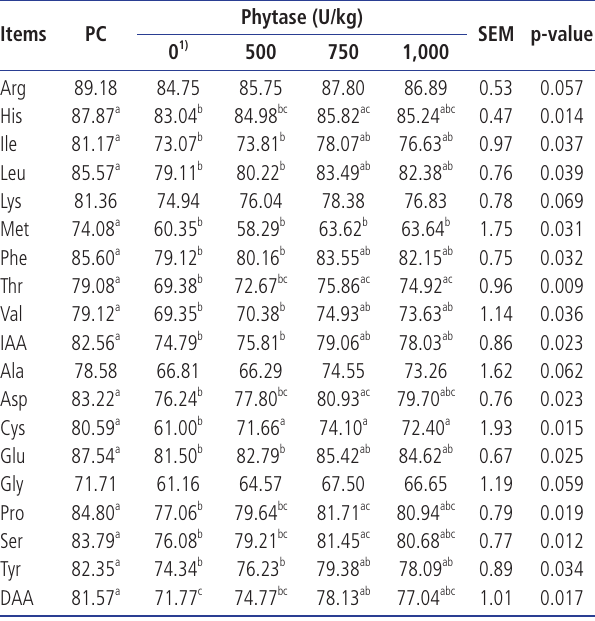
Table 6. Effect of phytase on apparent ileal digestibility of amino acid in 63-d old Youxian Sheldrake